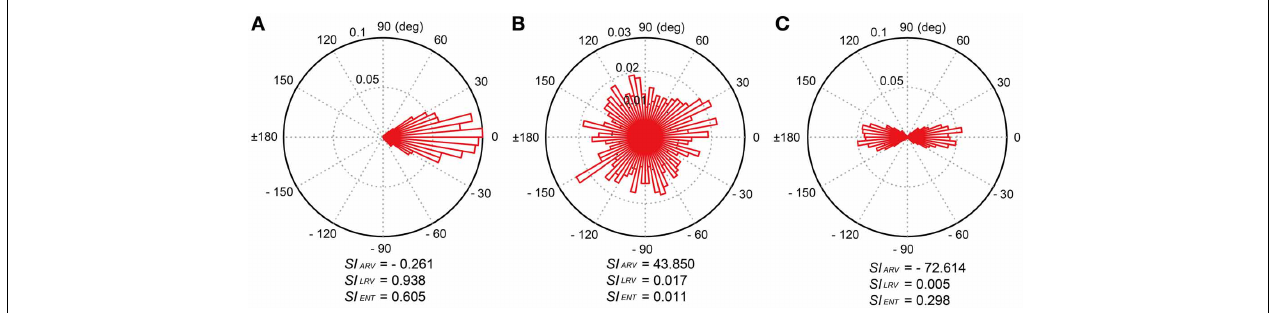
FIGURE 4 | Examples of relative-phase distribution and calculated synchronization indices ( SI s). There were three SIs ; (1) angle of resultant vector ( SI ARV ), (2) length of resultant vector ( SI LRV ), and (3) entropy of relative phase distribution ( SI ENT ). (A) Uni-modal relative-phase distribution around 0